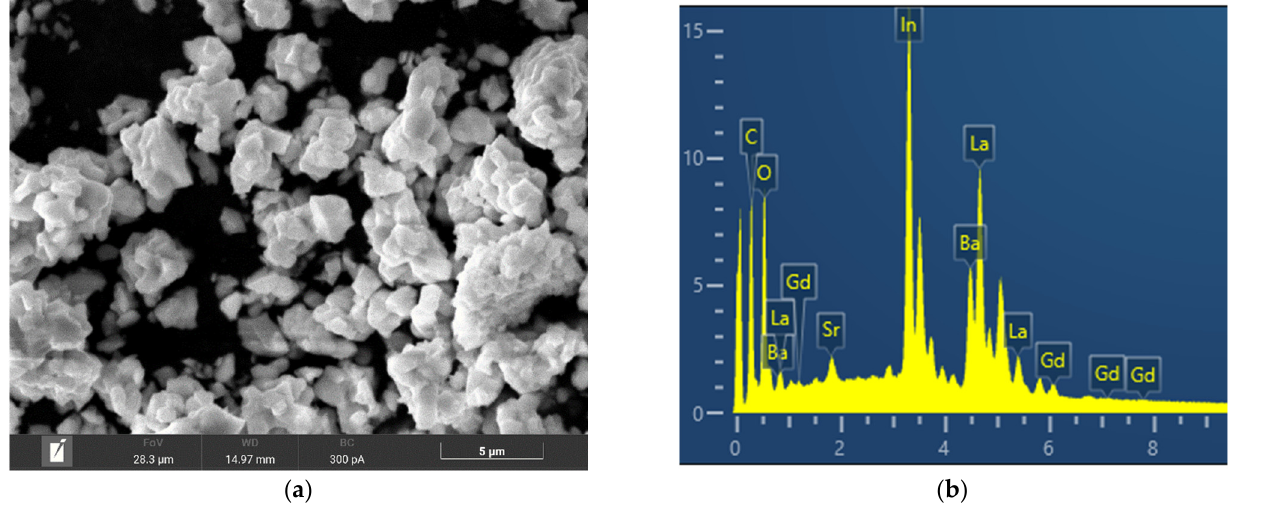
Figure 2. SEM ( a ) and EDX ( b ) results for the composition BaLa 1.8 Sr 0.1 Gd 0.1 In 2 O 6.95. Table 2. The average element ratios determined by EDS analysis for the samples BaLa 2 In 2 O 7 (1), BaLa 1.85 Sr 0.05 Gd 0.1 In 2 O 6.975 (2), BaLa 1.8 Sr 0.1 Gd 0.1 In 2 O 6.95 (3), BaLa 1.75 Sr 0.15 Gd 0.1 In 2 O 6.925 (4) (theoretical val-